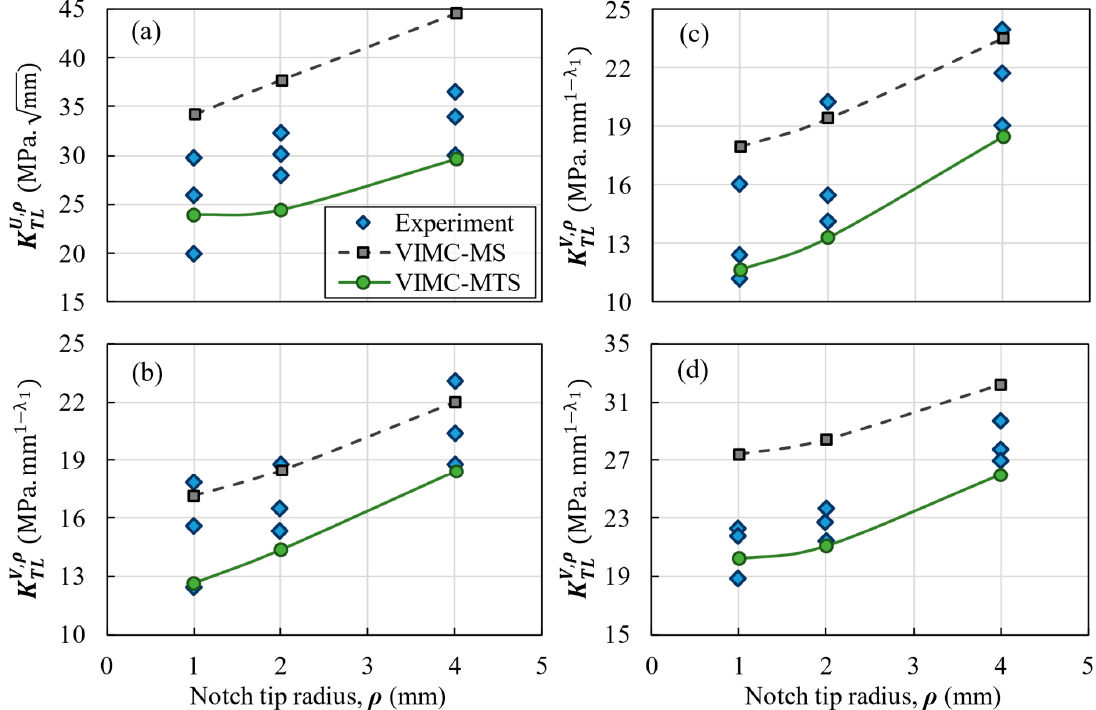
Figure 9. Experimental and predicted TLNFT of the quasi-isotropic laminate versus the notch-tip radius. ( a ) U-notch; ( b ) V-notch with a 30 ◦ opening angle; ( c ) V-notch with a 60 ◦ opening angle; ( d ) V-notch with a 90 ◦ opening